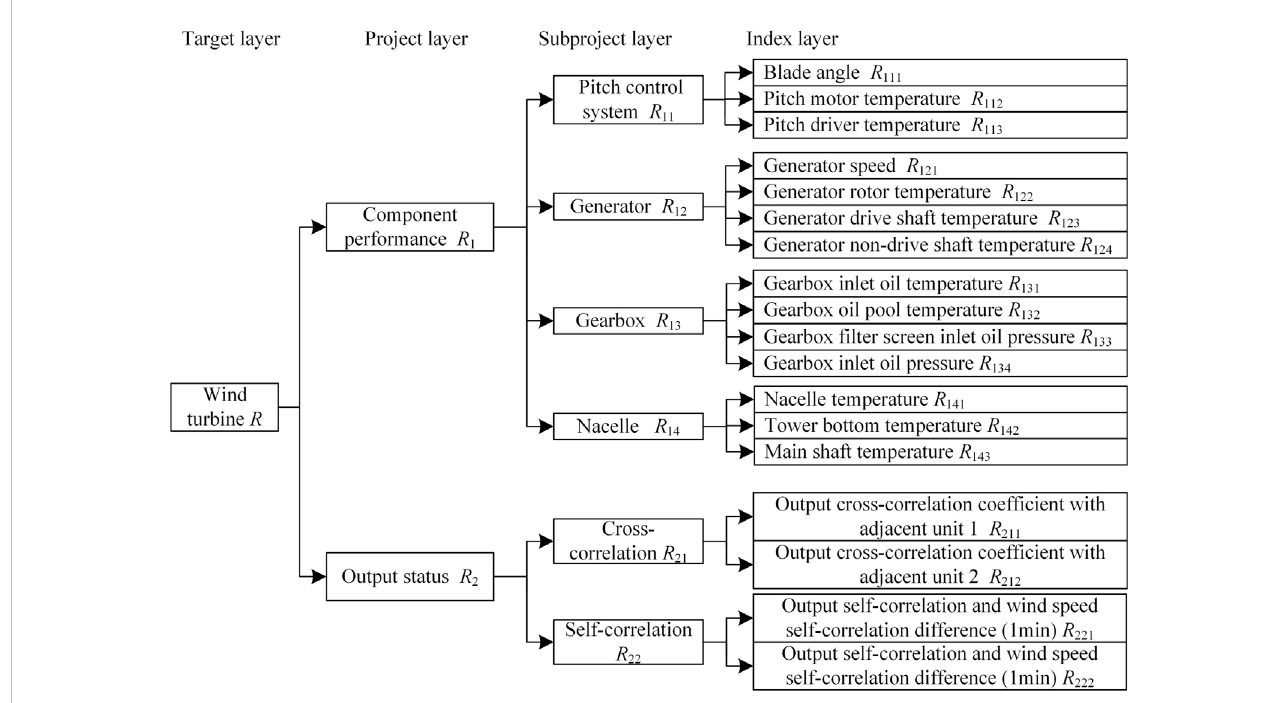
FIGURE 1 Hierarchical structure of wind turbine evaluation